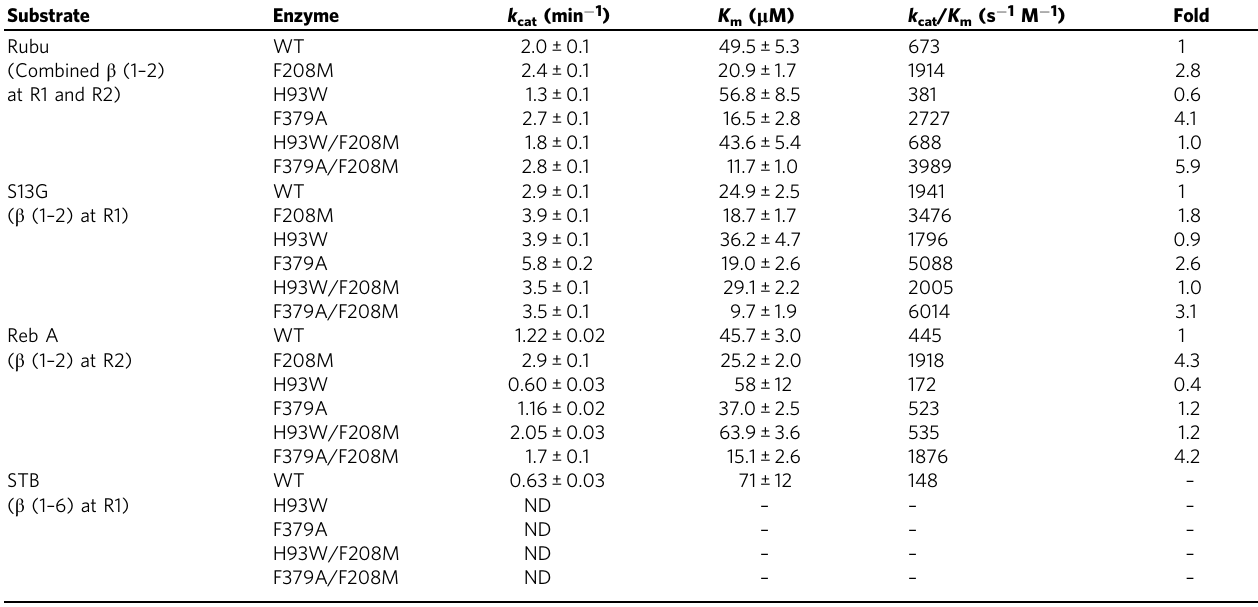
Table 1 Enzyme kinetic parameters for the sugar transfer of OsUGT91C1 and the mutants.